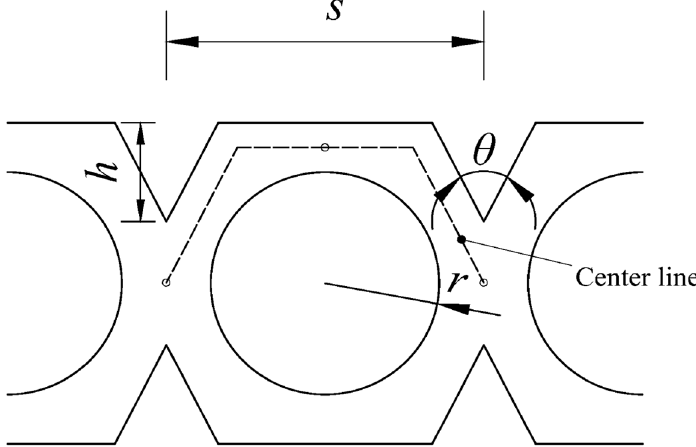
Figure 1. Schematic diagram of the CWRLC unit structure.